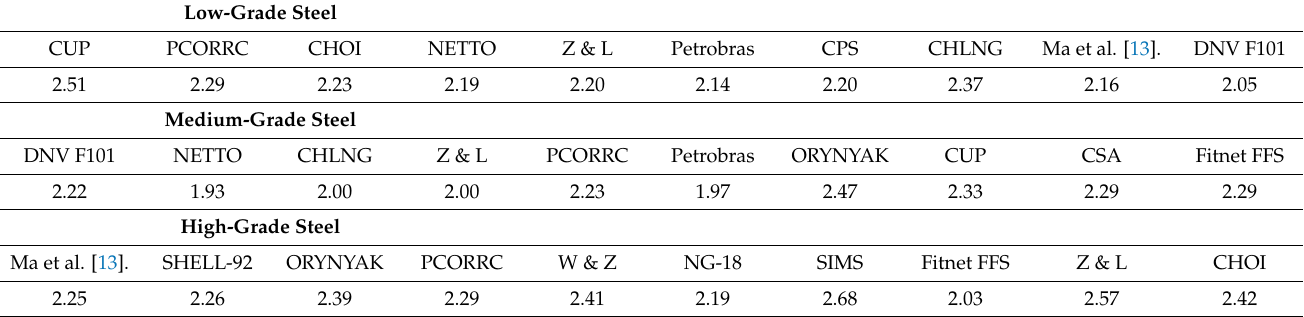
Table 3. Reliability indices ( β ) calculated using 10 top strength models in three steel categories at T o .